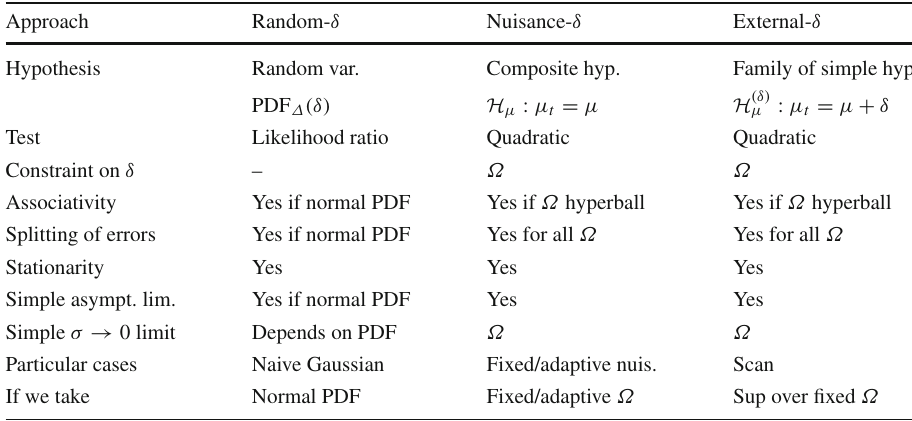
Table 1 Summary table of various approaches to theoretical